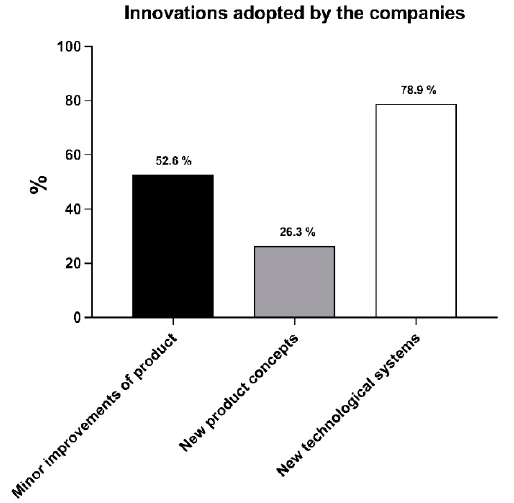
Figure3. Innovationsadoptedbythecompanies. Source: Author’scalculationfromtheresearchdataset. Figure 3. Innovations adopted by the companies. Source: Author’s calculation from the research dataset.